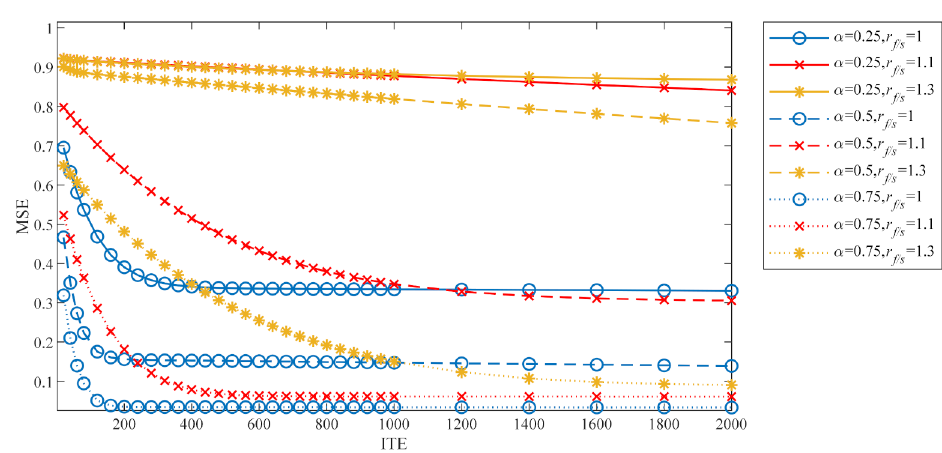
Figure 1. The MSE between f and g ITE at different iteration filter